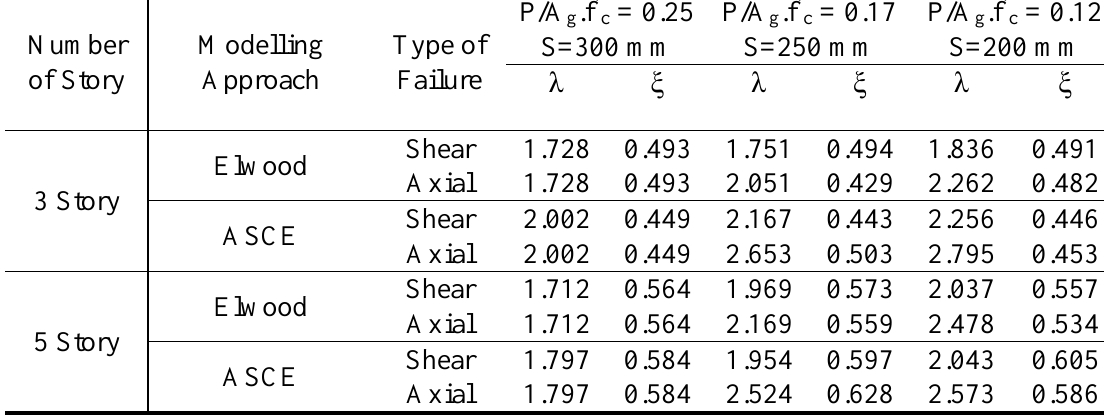
Statistic results of the calculation of mean and standard deviation.